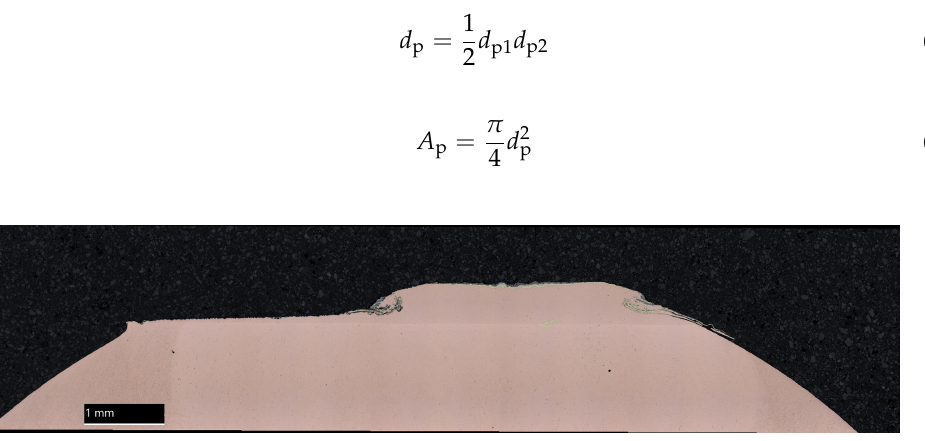
Figure 15. Plateau forming due to axial material flow of lower electrode of MC02–TS02 after 822 spot welds in cross-section [11].